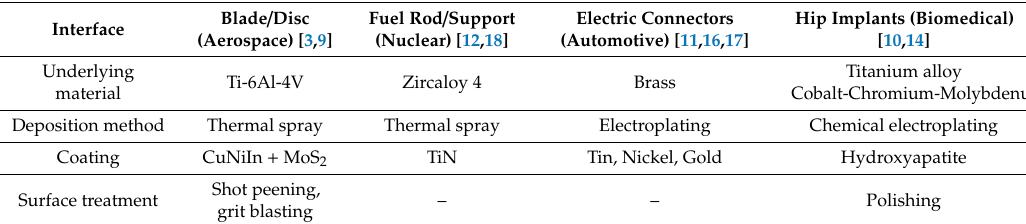
Table 2. Example of anti-fretting coatings.